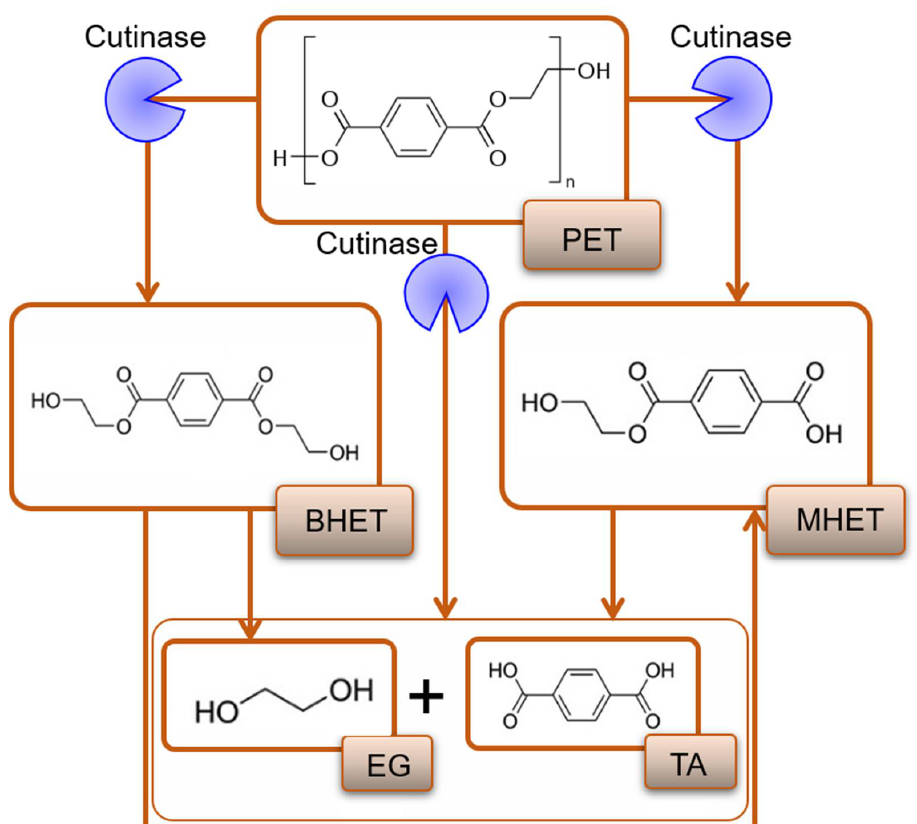
Figure 3. Cutinases mediated catalytic breakdown of PET into its subunits.